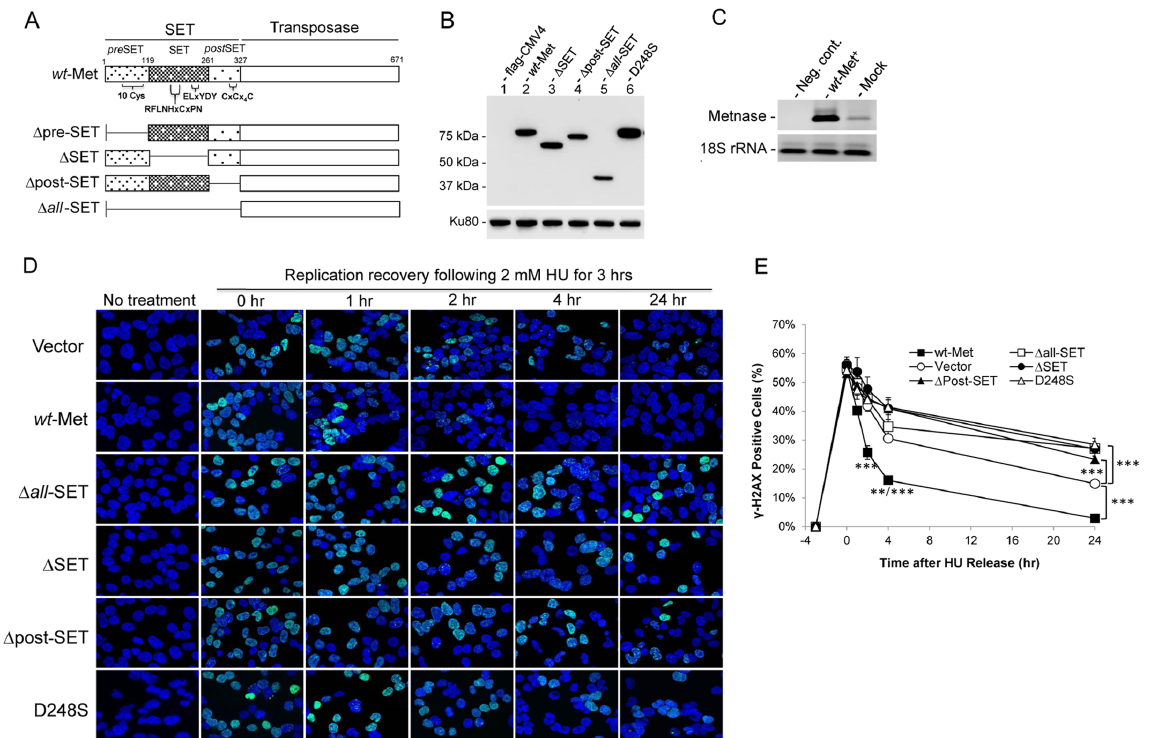
Fig 1. The Metnase SET domain is necessary for replication recovery after long exposure to hydroxyurea (HU). (A) Schematic diagram of Metnase. The Metnase SET domain comprises pre-SET (aa 14 – 118), SET (aa 119 – 260), and post-SET (aa 261 – 326) domains. The pre SET domain contains a cysteine-rich putative Zn +2 binding motif (10 Cys), while the SET domain has the SAM binding motif (207-RFLNHxCxPN----ELxYDY-248) for histone lysine methyltransferase activity. The post -SET domain also contains a cysteine-rich putative Zn +2 binding motif (CxCx 4 C). (B) Western blot analysis of flag-tagged wt-Metnase and the SET mutants that were stably expressed in HEK293 cells. Thirty μ g of cell extracts were loaded onto 10% SDS-PAGE for immunoblot analysis. Ku80 was used as a loading control. (C) Metnase expression in control HEK293 cells (mock) and wt-Metnase overexpressor (wt-Met + ) was analyzed by RT-PCR. (D) Representative confocal microscope images of HEK293 cells stably transfected with pCMV4 vector (top row), wt-Metnase (second row), and the SET mutants (third to sixth row) following HU treatment. After treatment of 2 mM HU for 3 hrs, cells were released into fresh media at indicated times, stained with DAPI (blue) and an antibody to γ -H2AX (green), and imaged by confocal microscopy. (E) Quantitation of γ -H2AX-positive cells in panel D. Plots were average percentages ( ± SD) of γ -H2AX-positive cells. An average of 200 cells were counted per slide, 6 slides per experiment. ** , P < 0.01; *** , P < 0.005, t